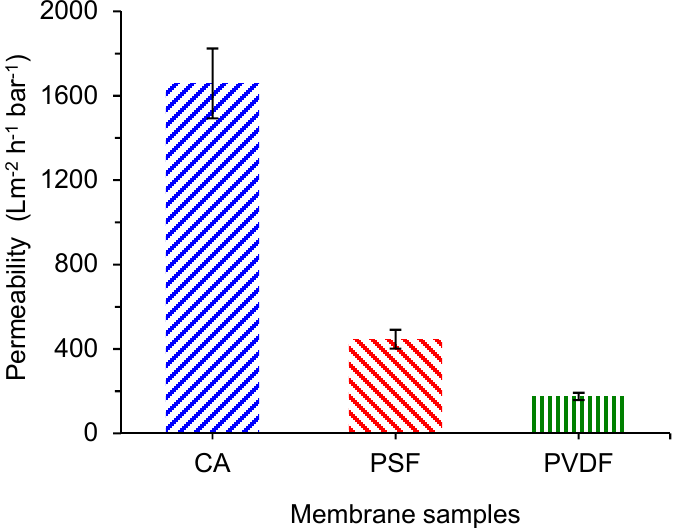
Figure 7. Clean water permeability of the cellulose acetate (CA), polysulfone (PSF), and polyvinyli- dene difluoride (PVDF)